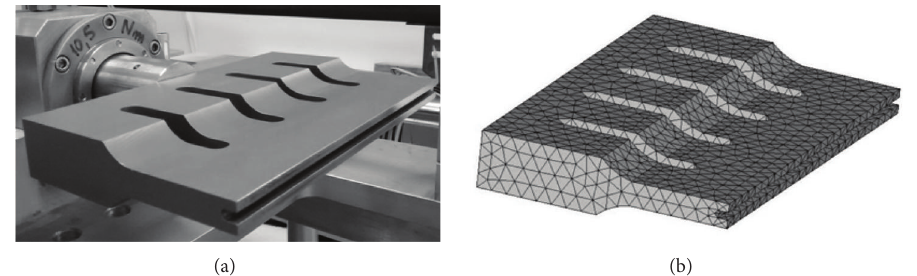
Figure 2: Ultrasonic sonotrode investigated (a) and its finite element model (b).